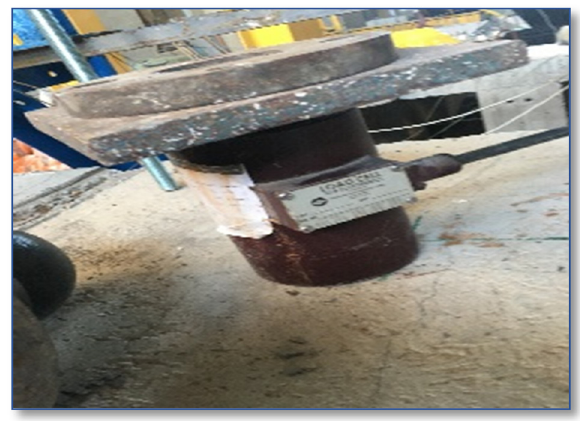
Figure 3: The calibration sample of 2.5 kg